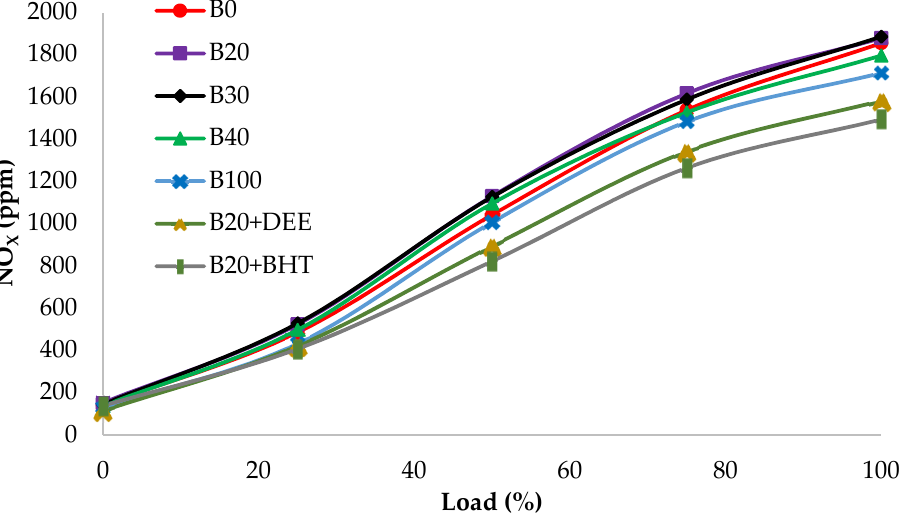
Figure 10. NO X emission of all fuel blends at different engine loads. Figure 10. NOx emission of all fuel blends at different engine loads.